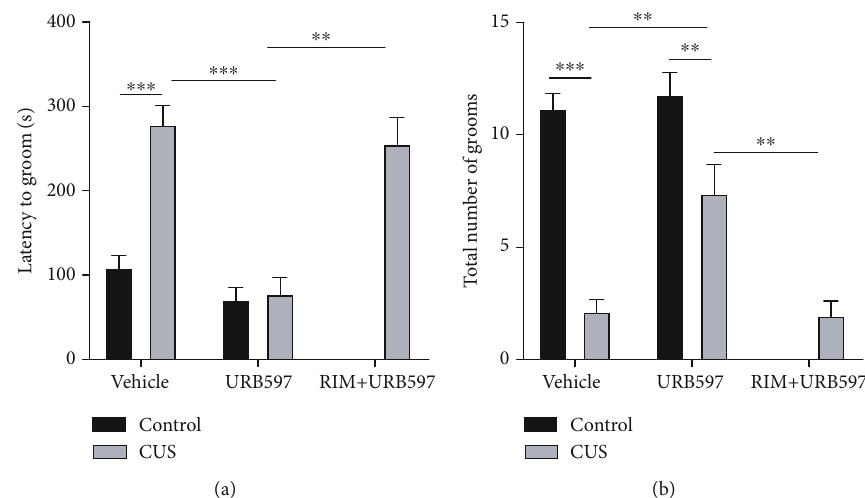
Figure 5: (a) Latency time to fi rst grooming. (b) Total frequency of grooming. Columns represent mean ± SEM , n = 12 /group; ∗∗ p ≤ 0 : 01 ; ∗∗∗ p ≤ 0 : 001 . Two-way ANOVA post hoc Holm-Sidak ’ s.